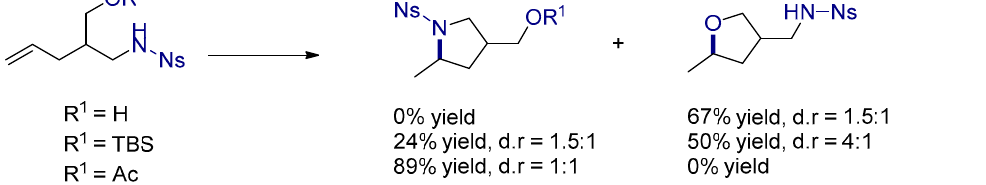
Figure 12. Cobalt-salen promoted cyclohydroamidation of N -protected amines tethered to mono- and 1,1 (cid:48) -disubstituted alkenes. rt = room temperature, d.r = diasteromeric